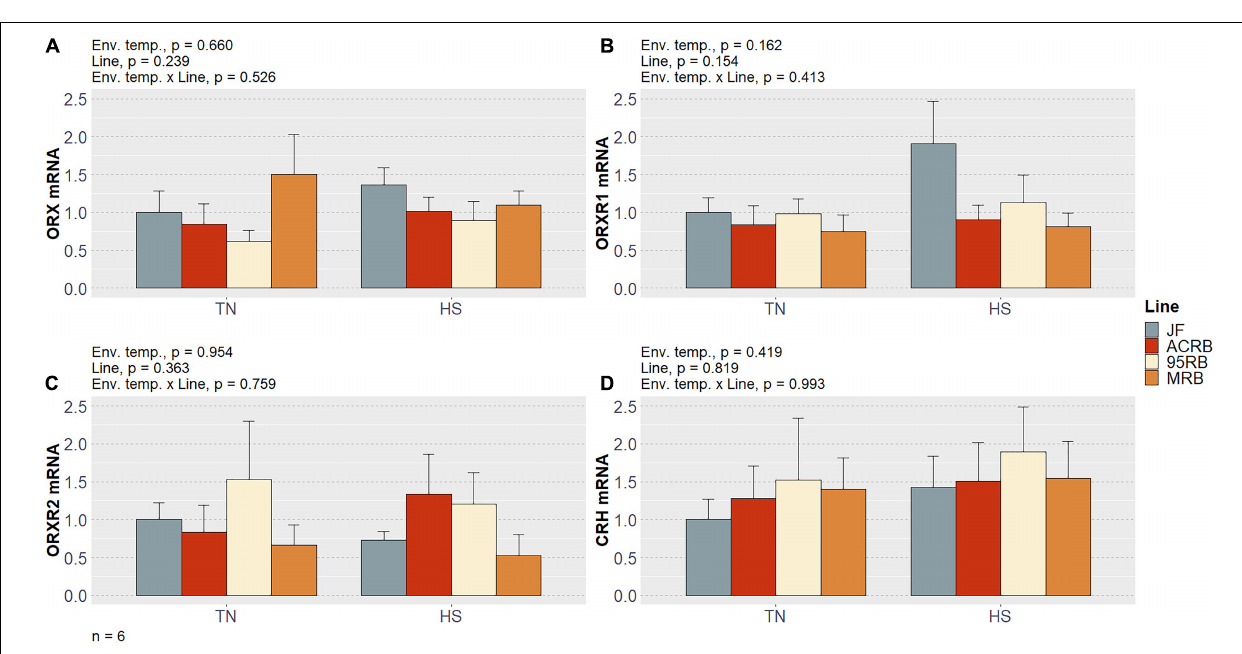
FIGURE 3 | Effect of cyclic heat stress on the hypothalamic expression of the orexin system and CRH in JF and modern broilers. The expression of ORX (A) , ORXR1 (B) , ORXR2 (C) , and CRH gene (D) was determined by qPCR using 2 − (cid:49)(cid:49) Ct method. JF-TN group was used as a calibrator. Data are mean ± SEM ( n = 6 birds/group). HS, heat stress; TN,